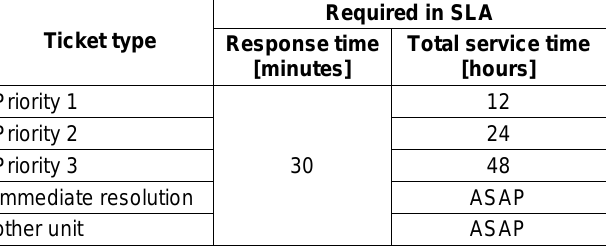
Table 4 – Required response time and Total service time for different ticket